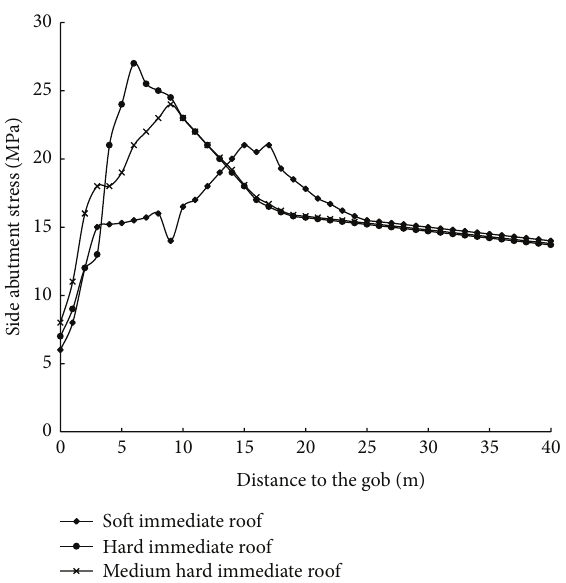
Figure 8: Distribution of the side abutment stress for the immediate roof with different